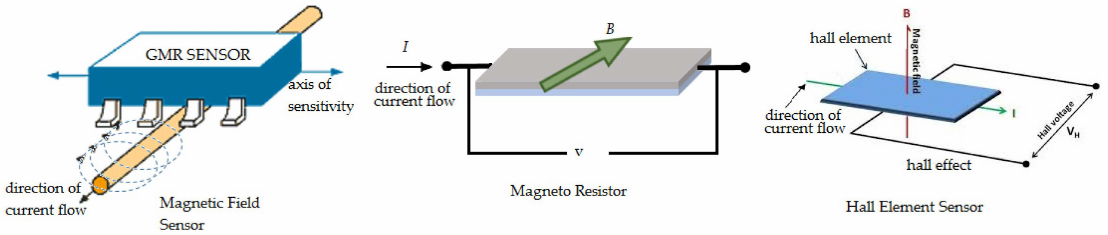
Figure 20. Hybrid probe [26,72]: ECT coil with magnetic field